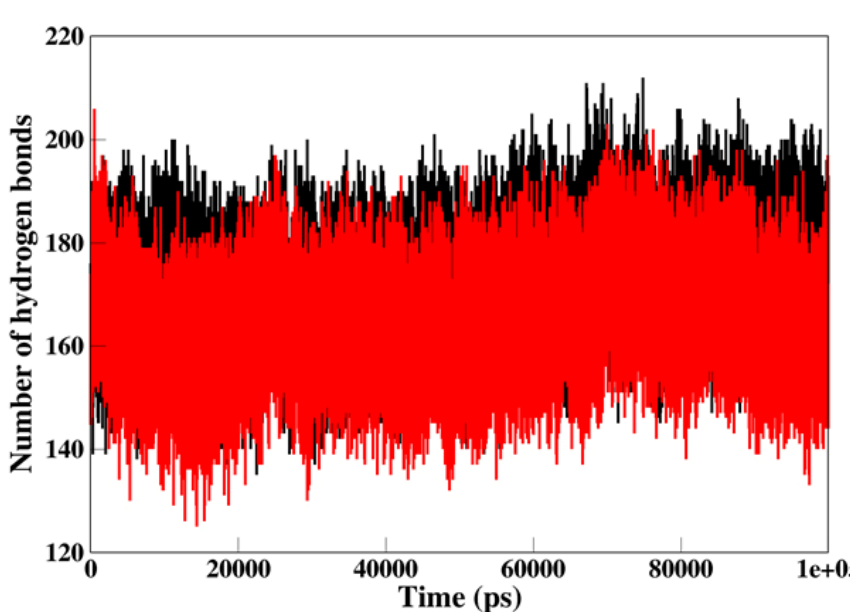
Figure 5. Hydrogen bond analysis. Intramolecular hydrogen bonds in apo (black color) and irisin- MARK4 complex (red color) were calculated after 100 ns MD simulation.